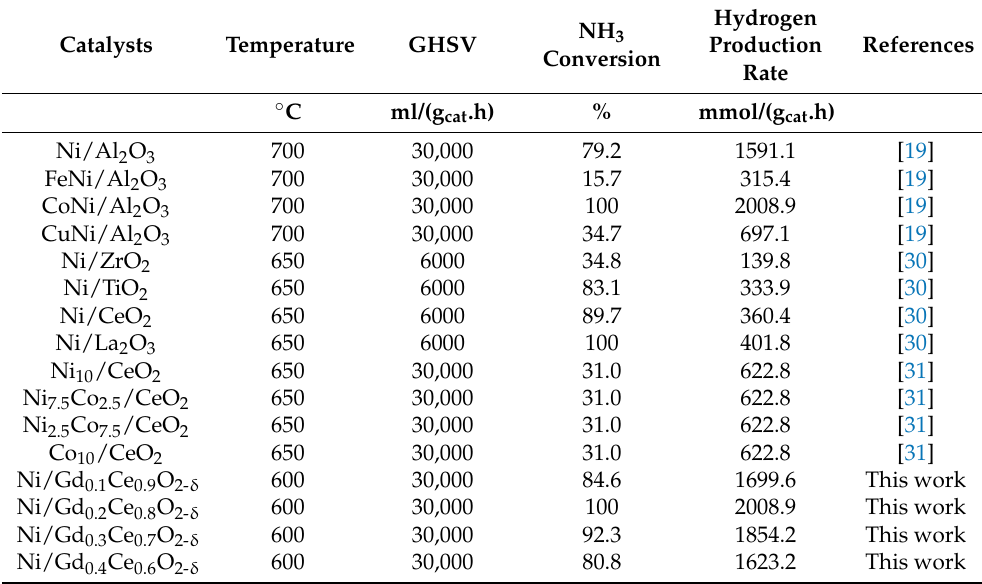
Table 3. Comparison of the catalytic activity of Ni/Gd x Ce 1-x O 2- δ with those in the